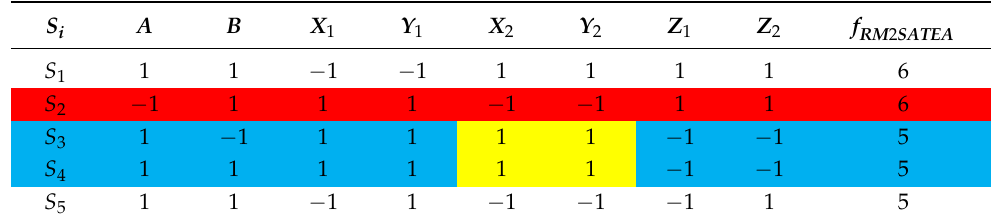
Table A5. S 2 remained as candidate in Party 1.